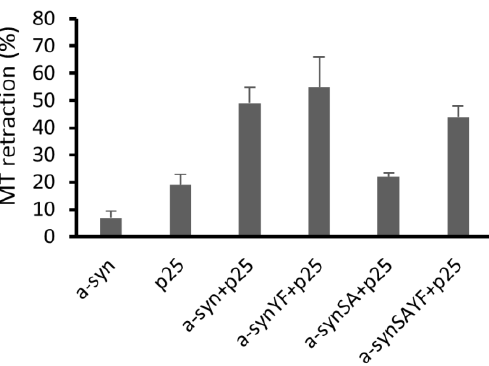
Figure 8. Removal of tyrosine at positions 125, 133, and 136 of α -synuclein (YF) abrogates a pro- tective effect of α -synuclein serine-129 to alanine (SA) mutation on microtubule (MT) retraction. Cellular degeneration is quantified as the percentage of cells displaying MT retraction [23]. OLN-93 cells transiently transfected with α -synuclein or p25a, a-synSA + p25, a-synYF + p25, a-syn SAYF + p25 and subjected to immunofluorescence microscopy 24h post-transfection using antibodies against total α -synuclein and α -tubulin. By mutating the three tyrosines (YF), rescue of MT retraction other- wise obtained by the SA mutation is abrogated in this MT retraction assay. The data are representative of at least three independent experiments. Data are compared using one-way ANOVA followed by Sidak post hoc test for multiple comparisons.